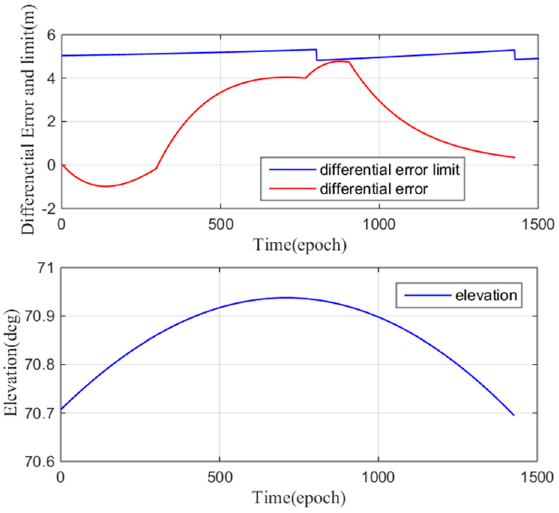
Figure 24. ( top ) Maximum difference correction error and the monitoring threshold at high satellite elevation; ( bottom ) satellite elevation.